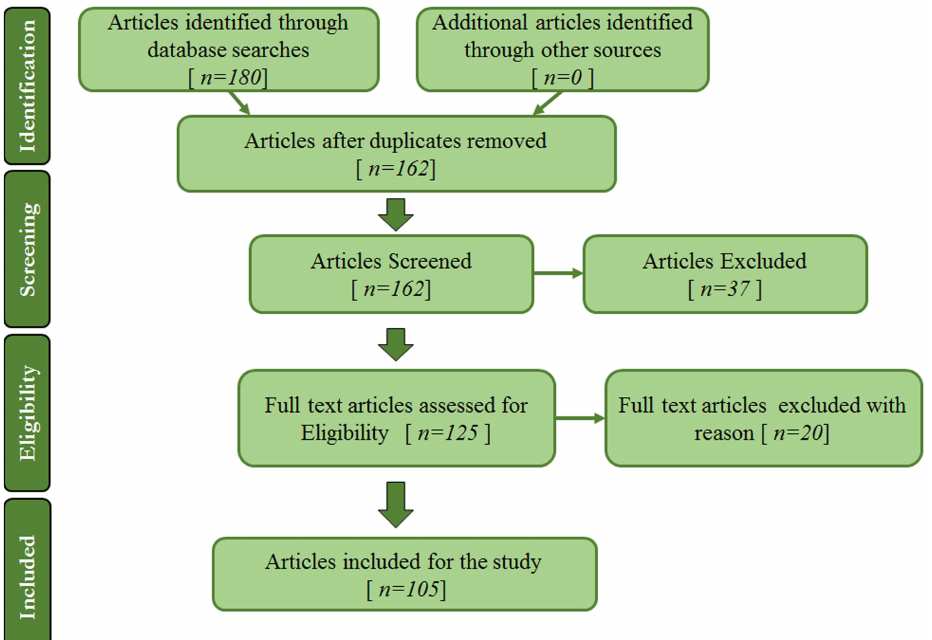
Figure 3. The PRISMA flow diagram and the selection